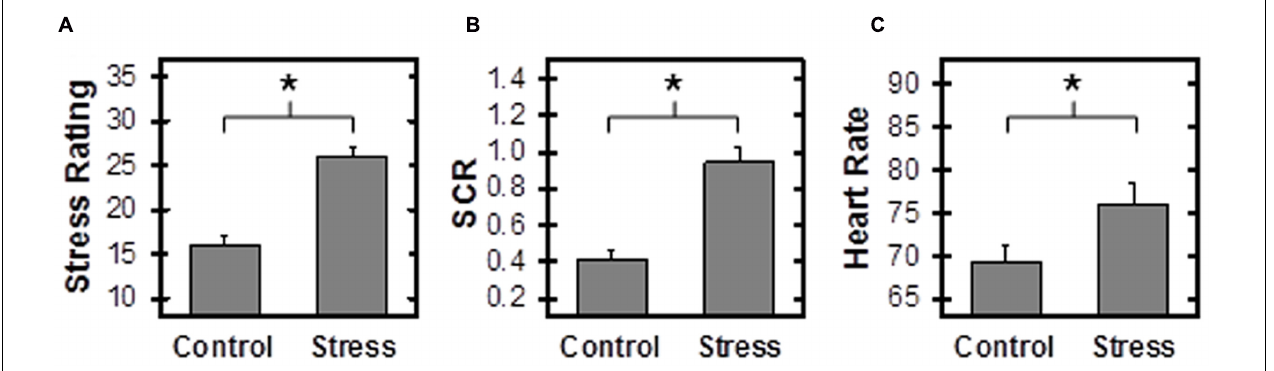
FIGURE 1 | Stress Response. Self-reported stress (A) , skin conductance response (SCR) (B) , and heart rate (HR) (C) were higher during Stress than Control Montreal Imaging Stress Task (MIST) conditions. SCR, Skin Conductance Response, calculated as the beta estimate of the SCRs to Math events. ∗ Reflects p < 0.05. TABLE 1 | Paired samples t -tests comparing Control to Stress Montreal Imaging Stress Task (MIST).